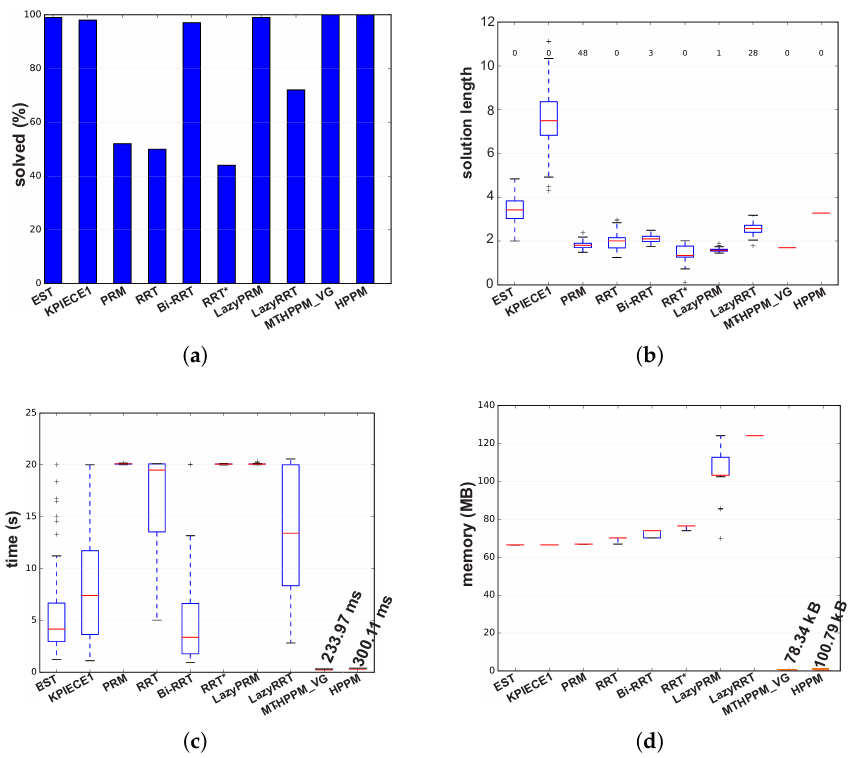
Figure 20. Comparative results for case study 2. ( a ) Successful paths. ( b ) Path length. ( c ) Execution time. ( d )